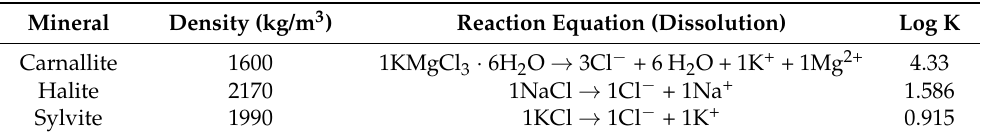
Table 1. Potash salt mineral densities and dissolution properties.